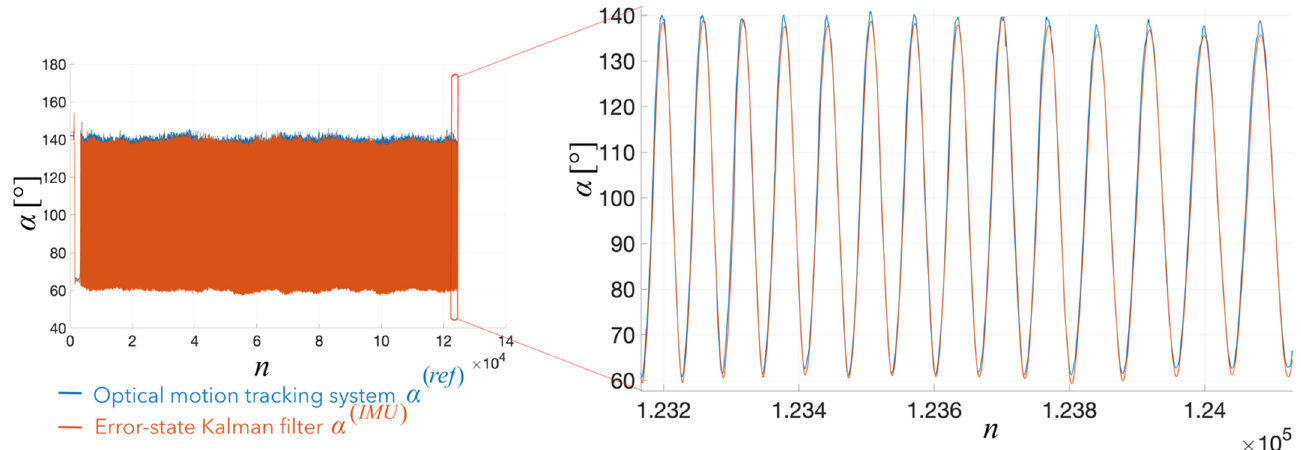
Figure 4. Synchronisation of results for longer measurement trials after using the LCSS